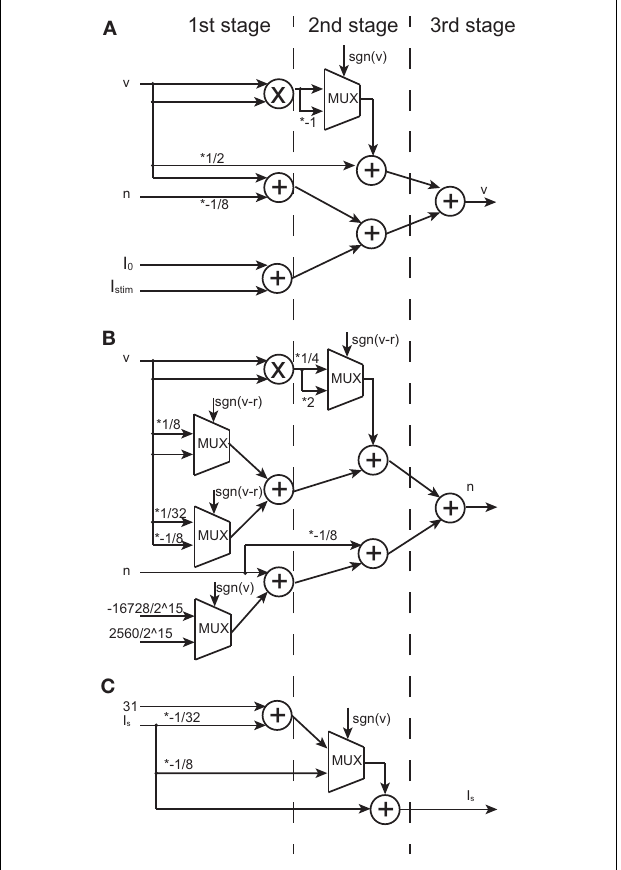
FIGURE 5 | Block diagrams of the v -, n -, and I s -circuits. Symbols × , + , and MUX mean a multiplier, an adder, and a multiplexer, respectively. Selection signal to the multiplexer sgn( v ) is the sign bit of v and the same to sgn ( v – r ).Values marked with * represent the multiplication that is realized by a right or a left shift operation. Multiplication by a negative value is realized by multiplication by its absolute and then bit inversion and increment. (A) The block diagram of the v -circuit, which costs 1 multiplier, 5 adders, and 1 multiplexer. (B) The block diagram of the n -circuit, which costs 1 multiplier, 5 adders, and 4 multiplexers.The logic units in (A,B) are compiled into the 3-stage pipeline structure. (C) The block diagram of the I s -circuit, which costs 2 adders and 1 multiplexer.This unit has the 2-stage pipeline structure. A multiplier is shared in (A,B) because their inputs are the